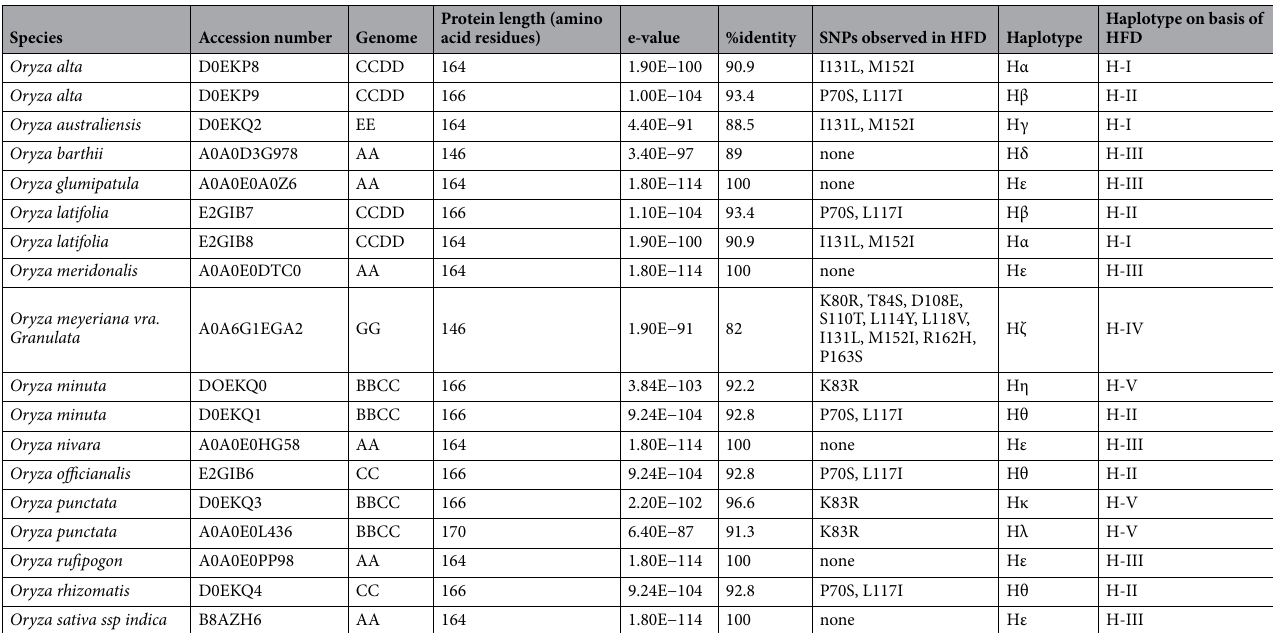
Table 4. Haplotype characterization of Oryza genus CENH3 protein sequences based off their alignment with rice CENH3: Haplotypes were mined on basis of variations observed in protein sequences when compared to